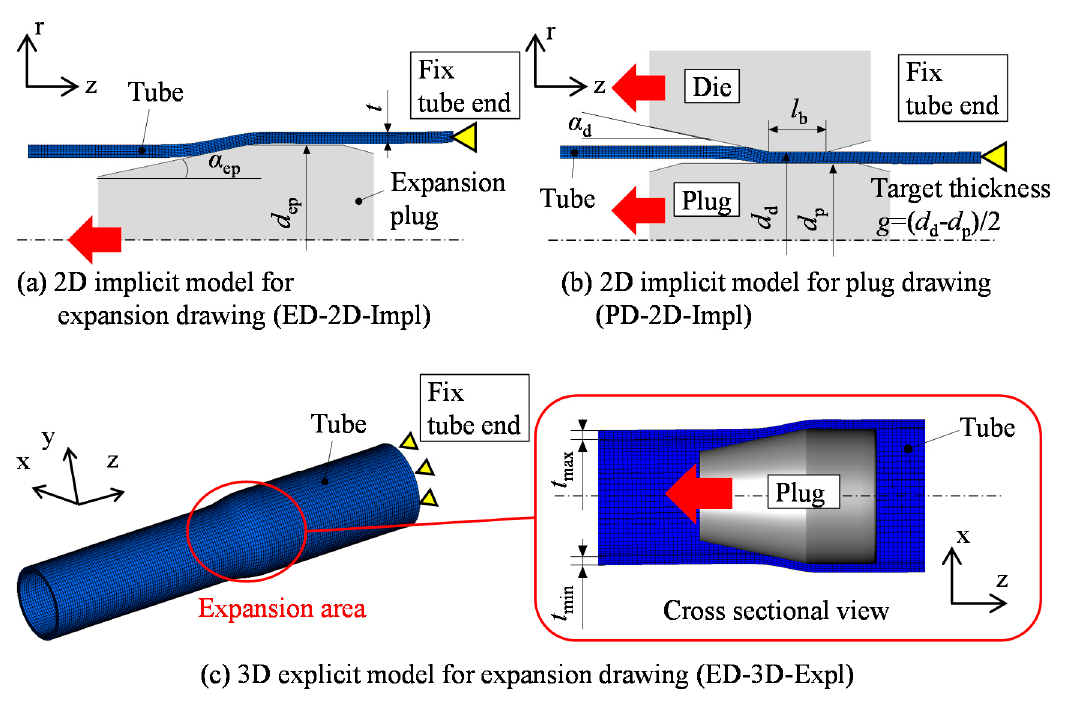
Figure 6. FEM models for drawing processes.